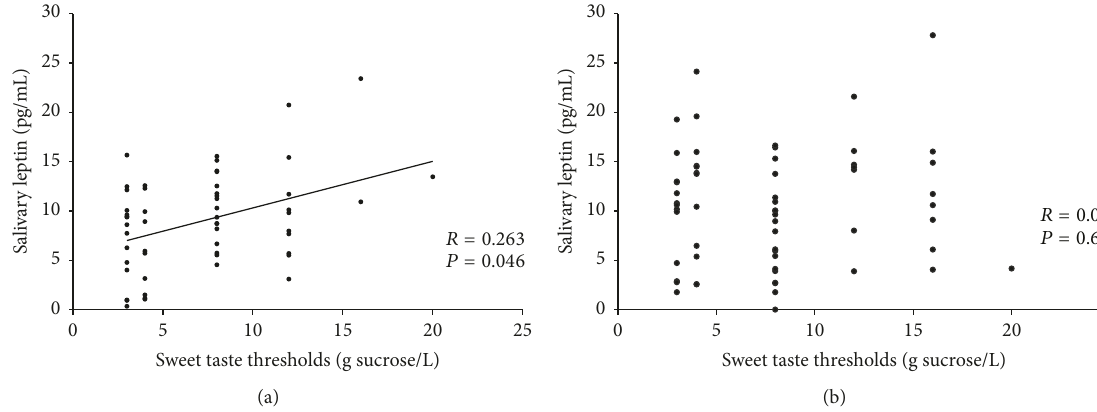
Figure 2: Correlation between sucrose thresholds and saliva leptin levels in girls (a) and boys (b); sweet taste thresholds correspondent to recognition of sucrose concentrations of 3.0, 4.0, 8.0, 12.0, and 16.0g/L.